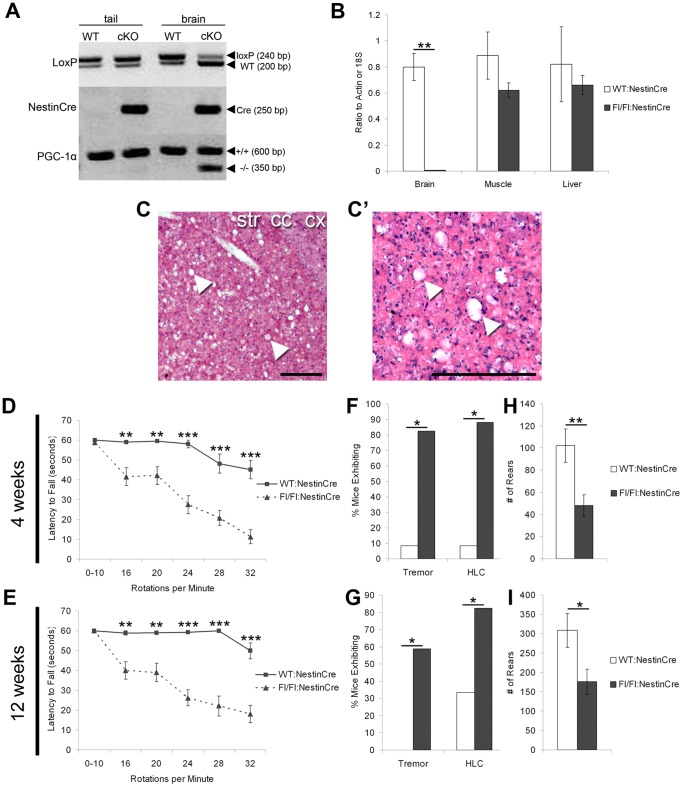
Nervous system deletion of PGC-1α recapitulates the behavioral and neurodegenerative phenotype of PGC-1α −/− mice.Nervous system conditional knockout (cKO) of PGC-1α was mediated by crossing PGC-1αfl/fl mice with mice expressing cre recombinase driven by the nestin promoter. A. Qualitative PCR from genomic DNA from homogenized tail or brain tissue demonstrates that recombination occurs in PGC-1αfl/+:NestinCre brain but not tail tissue. B. q-RT-PCR confirmed that PGC-1α transcript expression is significantly reduced in brain but not muscle or liver of PGC-1αfl/fl:NestinCre compared to WT:NestinCre animals. C. Hematoxylin and eosin (H&E) stained coronal sections from twelve-week-old PGC-1αfl/fl:NestinCre mice demonstrate spongiform vacuolation in the striatum. No vacuoles were present in PGC-1αWT:NestinCre littermates (data not shown). Higher magnification image shown in B′. Cx, cortex. Cc, corpus callosum. Str, striatum. Scale bars = 250 µm. D–E. PGC-1αfl/fl:NestinCre mice displayed impaired motor coordination with a decreased latency to fall off the of rotarod compared to PGC-1αWT:NestinCre at speeds of 16–32 rotations per minute at four (C) and twelve (D) weeks of age. F–G. PGC-1αfl/fl:NestinCre exhibited increased instance of tremor and hindlimb clasping (HLC) compared to PGC-1αWT:NestinCre mice at four (E) and twelve (F) weeks of age. H–I. PGC-1αfl/fl:NestinCre mice reared fewer times during a 30-minute open field protocol compared to PGC-1αWT:NestinCre littermates at four (G) and twelve (H) weeks of age. Other behaviors of interest, including ambulatory distance and time, did not differ between genotypes at either age. D–E, repeated-measure ANOVA followed by planned comparisons with the Holm-Bonferroni correction. F–G, chi square test for independence. B;H–I, two-tailed t-tests. *p<0.05. **p<0.005. *** p<0.0005. PGC-1αWT:NestinCre, n = 12; PGC-1αfl/fl:NestinCre, n = 18. Data presented as mean ± SEM.